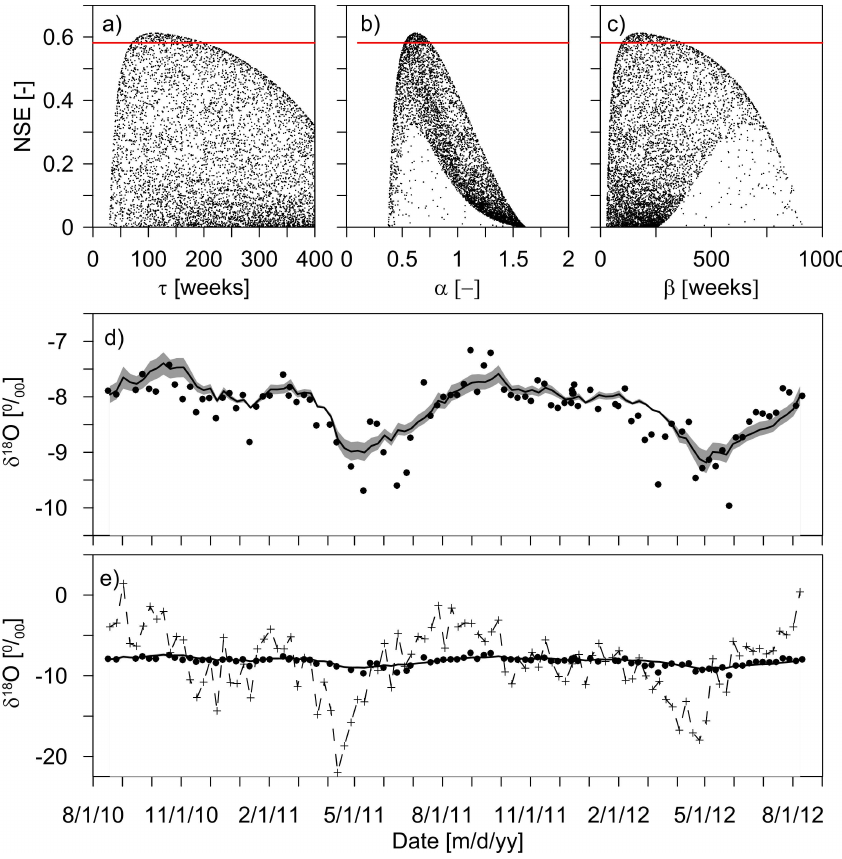
Fig. 12. Uncertainty ranges for outlet stream water (PL site) using a GM distribution function. (a) , (b) and (c) show the modeled parameters uncertainties of 10000 simulations and the feasible range of behavioral solutions taking a lower limit of 5% from the best solution. Black filled circles in (d) and (e) represent the observed data; the black line and the shaded area represent the best possible solution and its range of variation according to the 5–95% confidence limits of the behavioral solutions shown in (a) ; and the gray dashed line with crosses in (e) represents the weekly rainfall variation as an input function for the